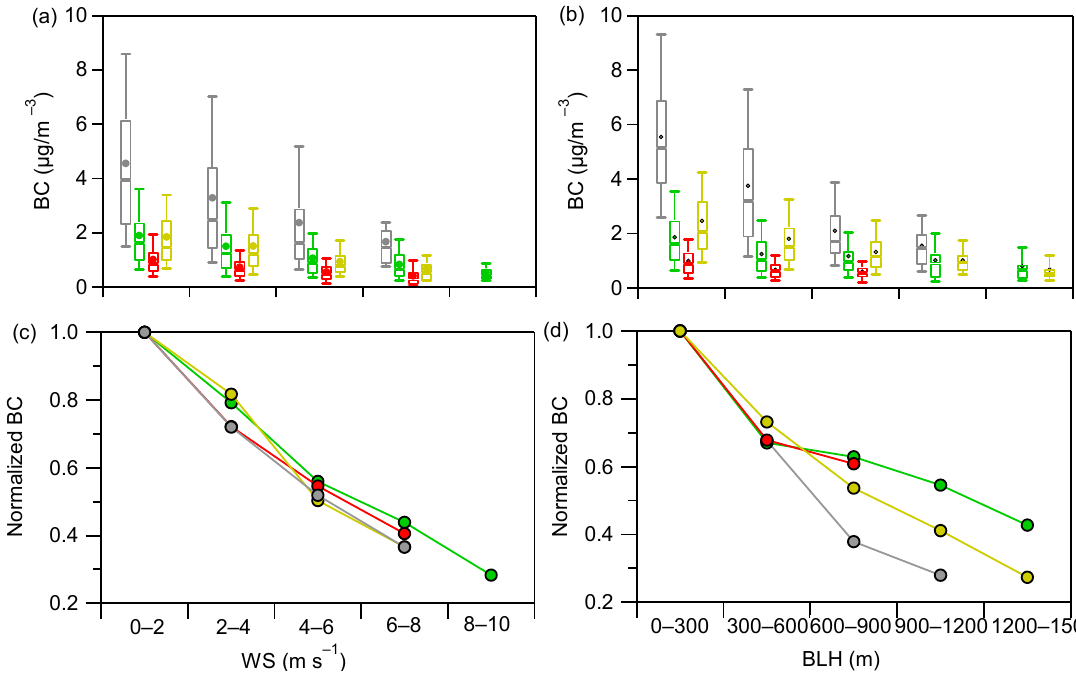
Figure 6. Mass concentration and normalized BC values as a function of ( a , c ) WS range and ( b , d ) BLH, respectively.